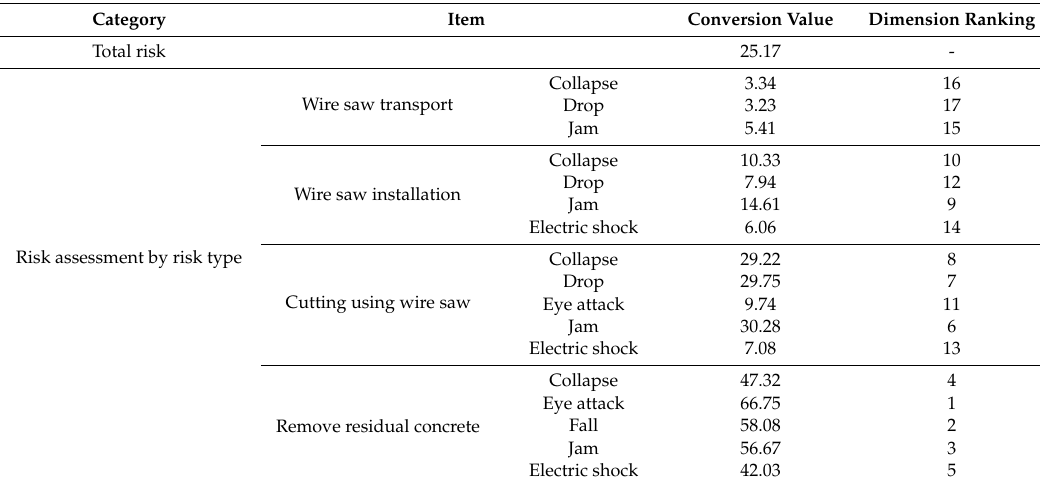
Table 13. Risk assessment results by work and risk